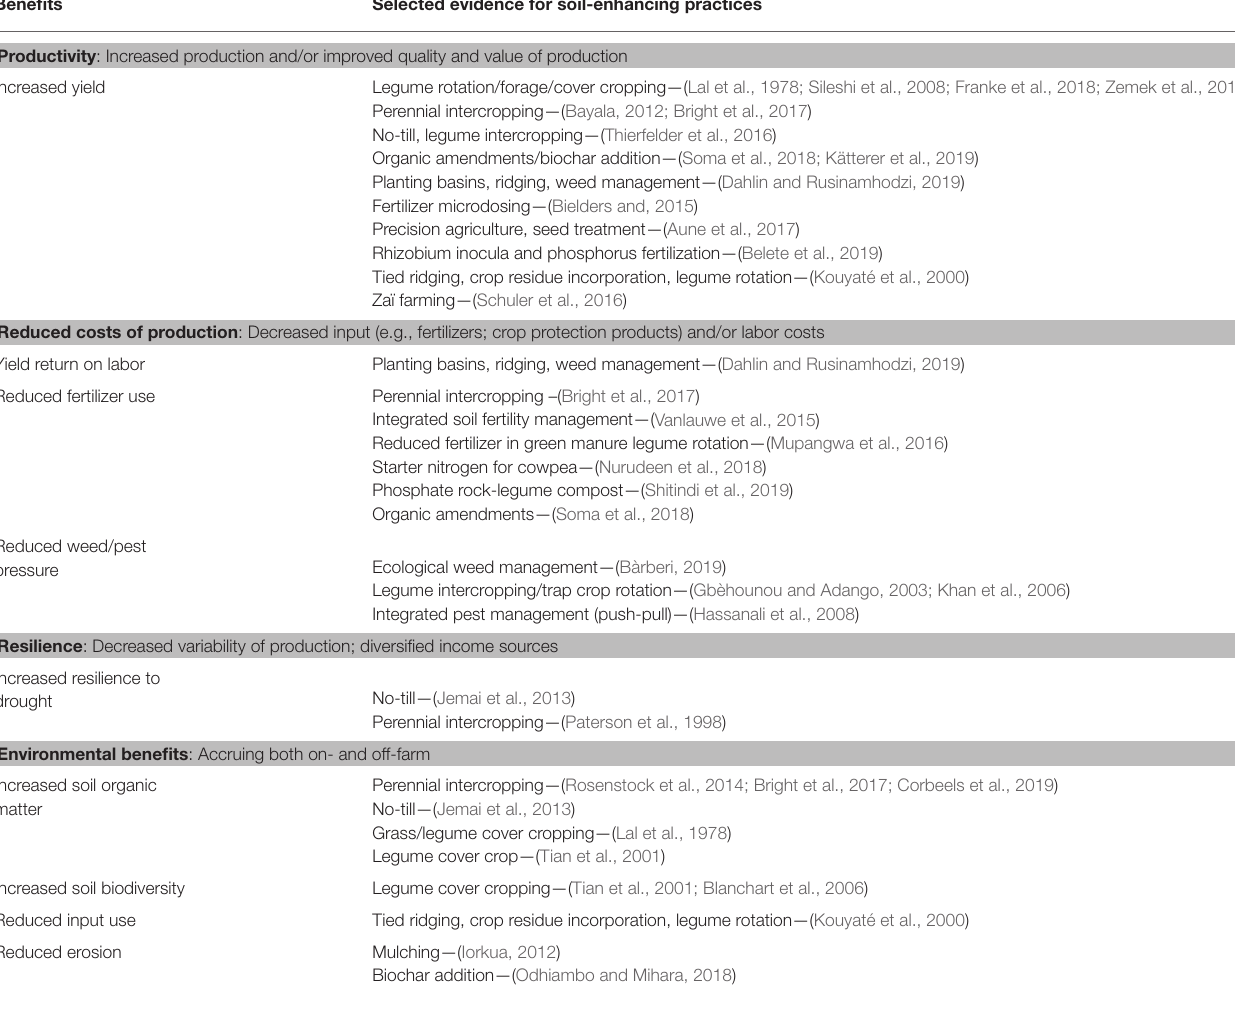
TABLE 1 | Selected evidence of biophysical changes and farm-level benefits from soil-enhancing